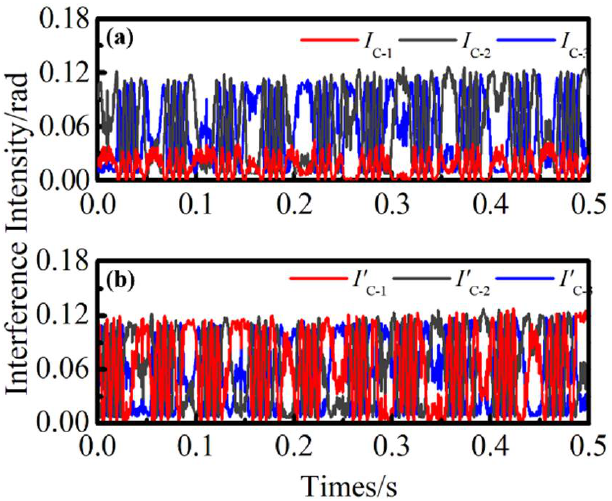
Figure 7. Original interference signal and compensated interference signal.